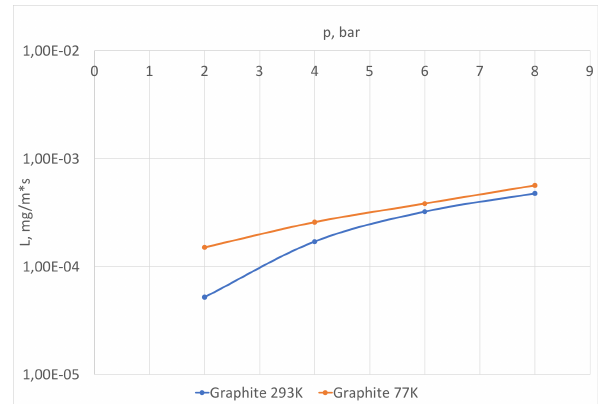
Figure 15: The compression of the leakage rate of particular gaskets at ambient and 77 K